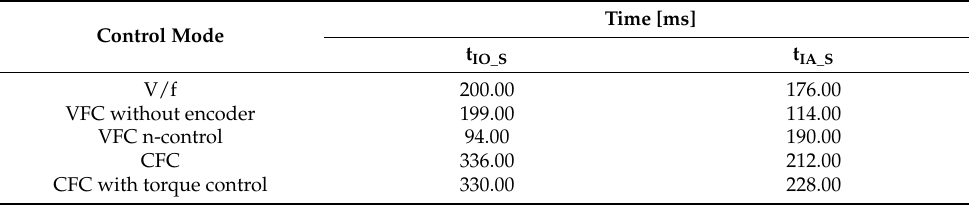
Table 13. Time characteristics of the output current (I O ) and the active current (I A ) in the transient state (with the external load).